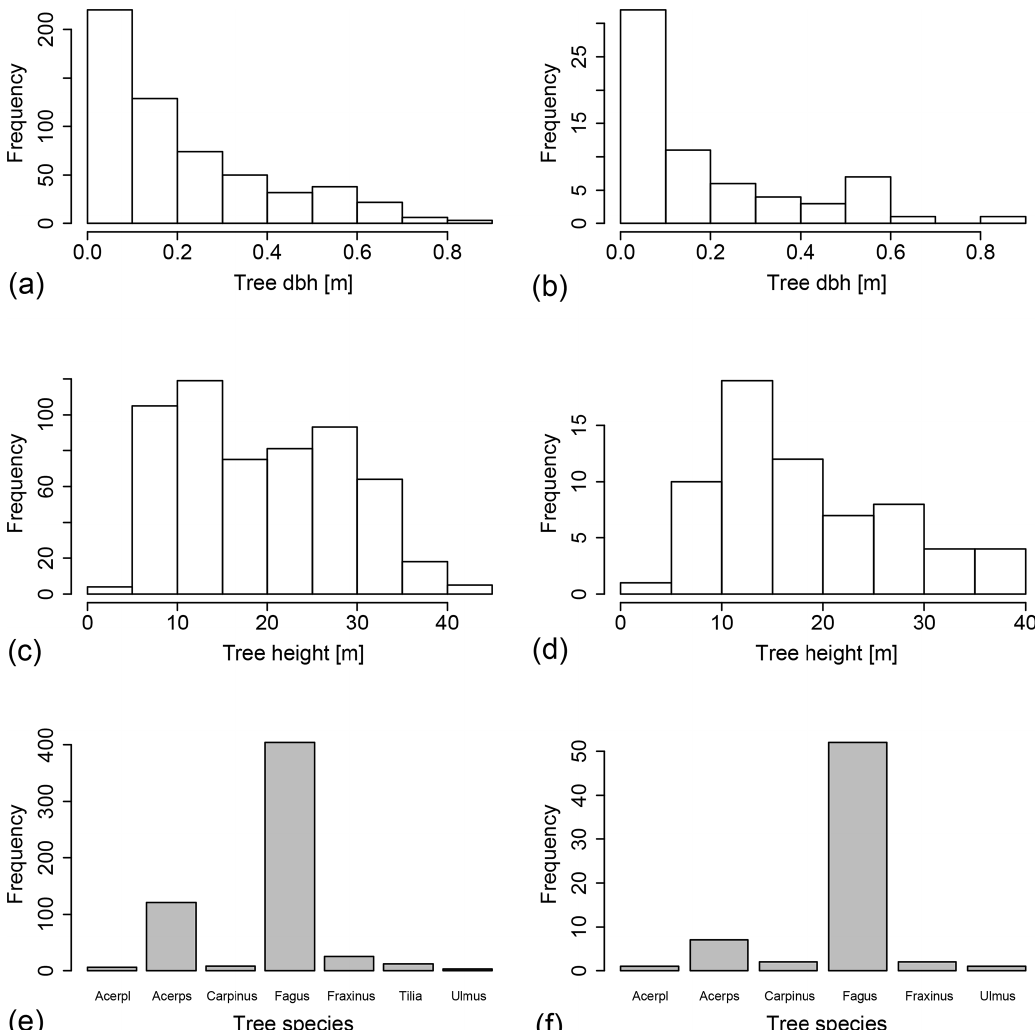
Figure A1. (a, c, e) Histograms of stand properties on the whole 1ha plot ( n = 581) and (b, d, f) the 11 100m 2 subplots on which stemflow was measured ( n = 65). “Acerpl” refers to Acer platanoides , and “Acerps” refers to Acer pseudoplatanus . Please see Table 2 for a list of the other occurring